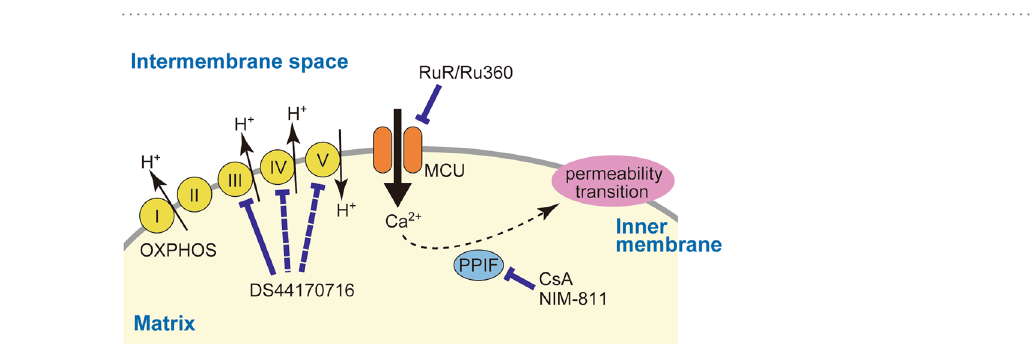
Figure 7. DS44170716 inhibits enzyme activities of respiratory chain complexes. ( a ) Effect of DS44170716 on enzyme activities of mitochondrial complex III. ( b ) Effect of DS44170716 on enzyme activities of mitochondrial complex IV. ( c ) Effect of DS44170716 on enzyme activities of mitochondrial complex V. Inhibition 0% or 100% was defined as the mean of vehicle-treated samples or samples that were maximally inhibited by the positive control. Data obtained from 3 independent samples are shown as the mean with SEM. Asterisk shows P < 0.05 compared to vehicle group (Dunnett’s test).